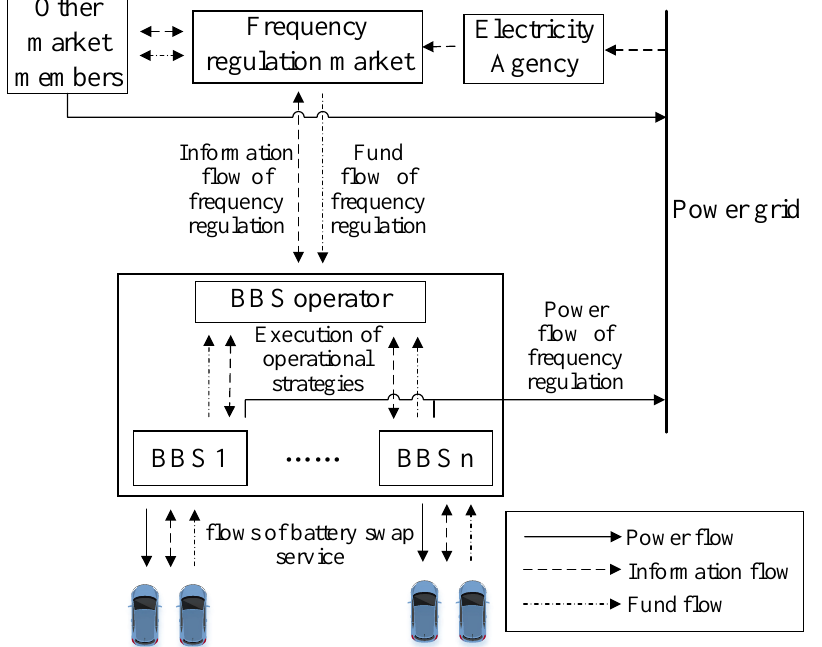
Figure 1. The business model of BSS cluster participating in FR service.